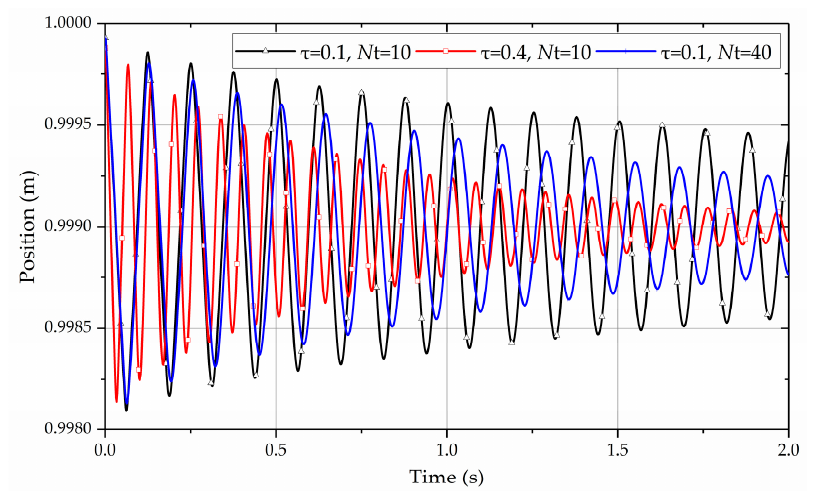
Figure 3. x-component of the position vector of the free tip with different parameters.